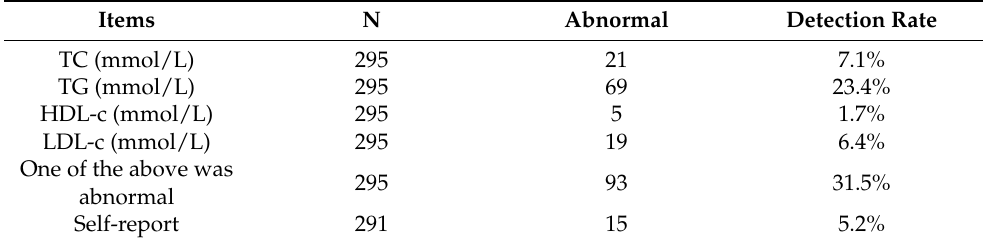
Table 2. The detection rates of abnormal blood lipids of pregnant women.